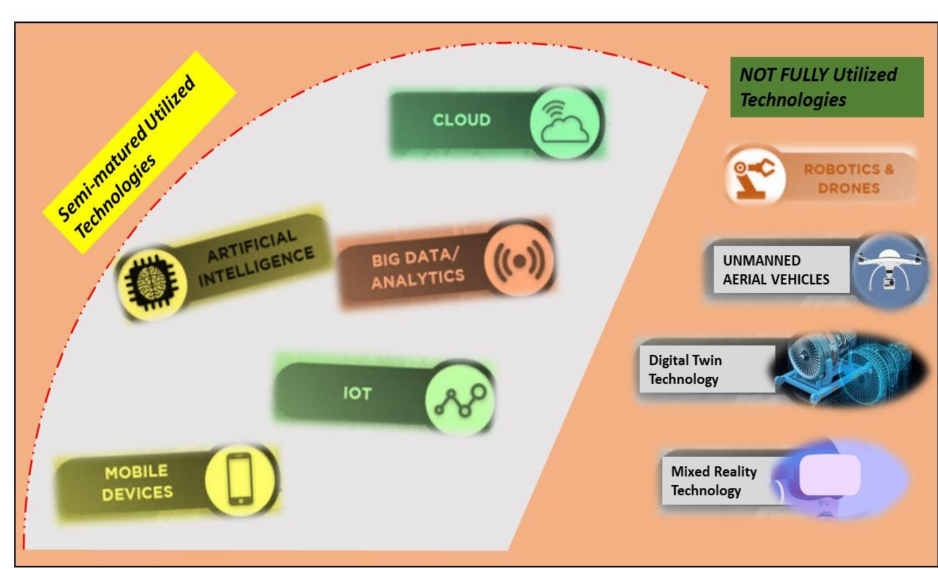
Figure 2. Emerging technologies adoption in drilling